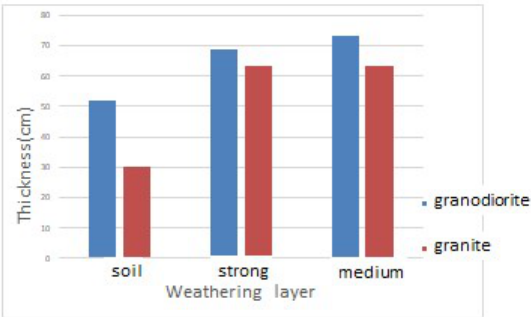
Figure 5 . Thickness of weathering layer in Abukuma Granite area